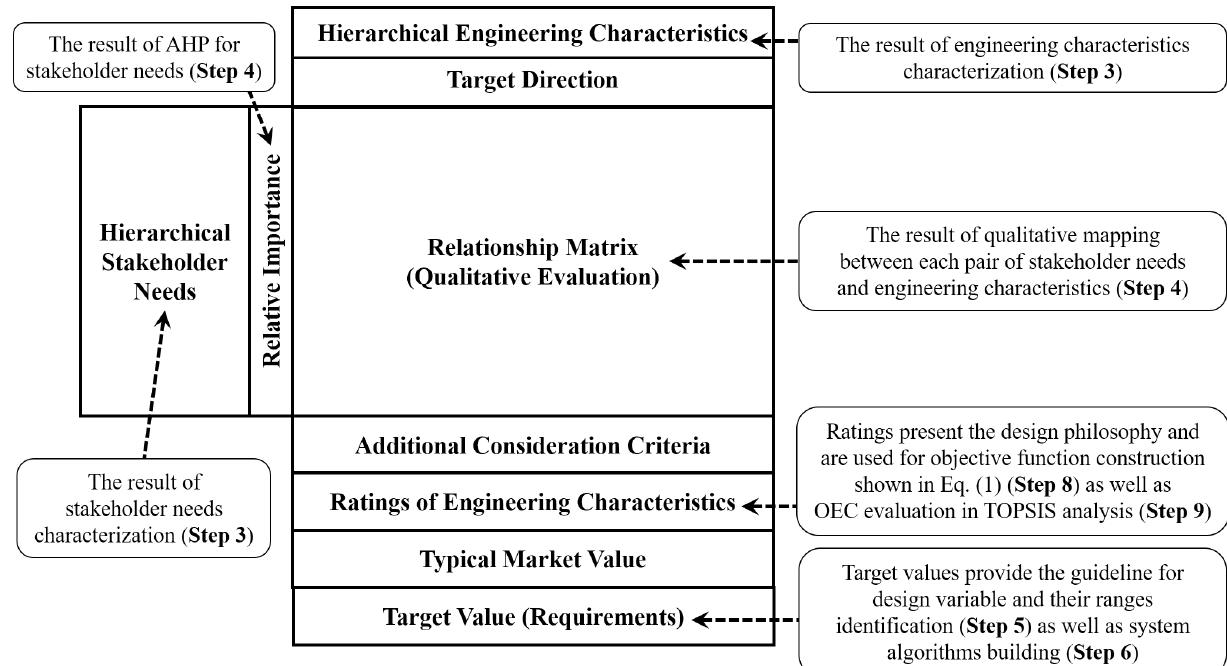
Figure 2. Schematic of QFD in the proposed approach.